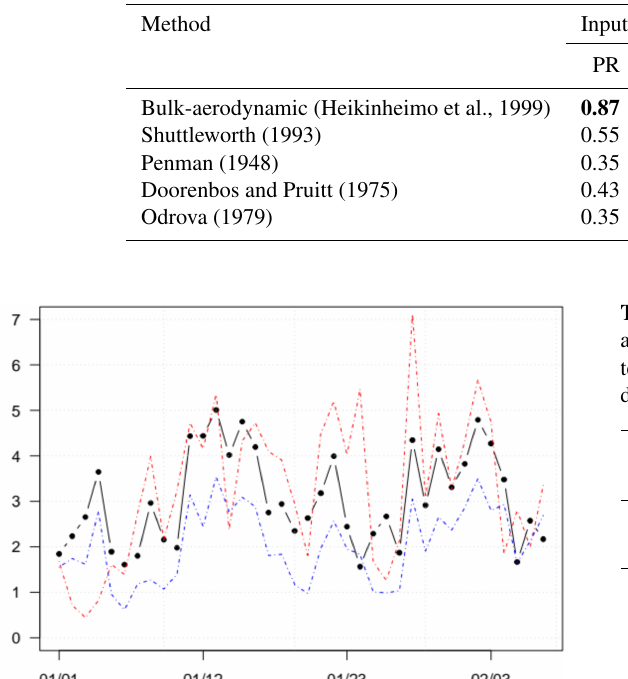
Table 4. The efficiency of the indirect methods with the Pearson correlation coefficient (PR), the root mean square error (RMSE), and the s/σ (SSC) criteria. Bold: best fit to the EC method.